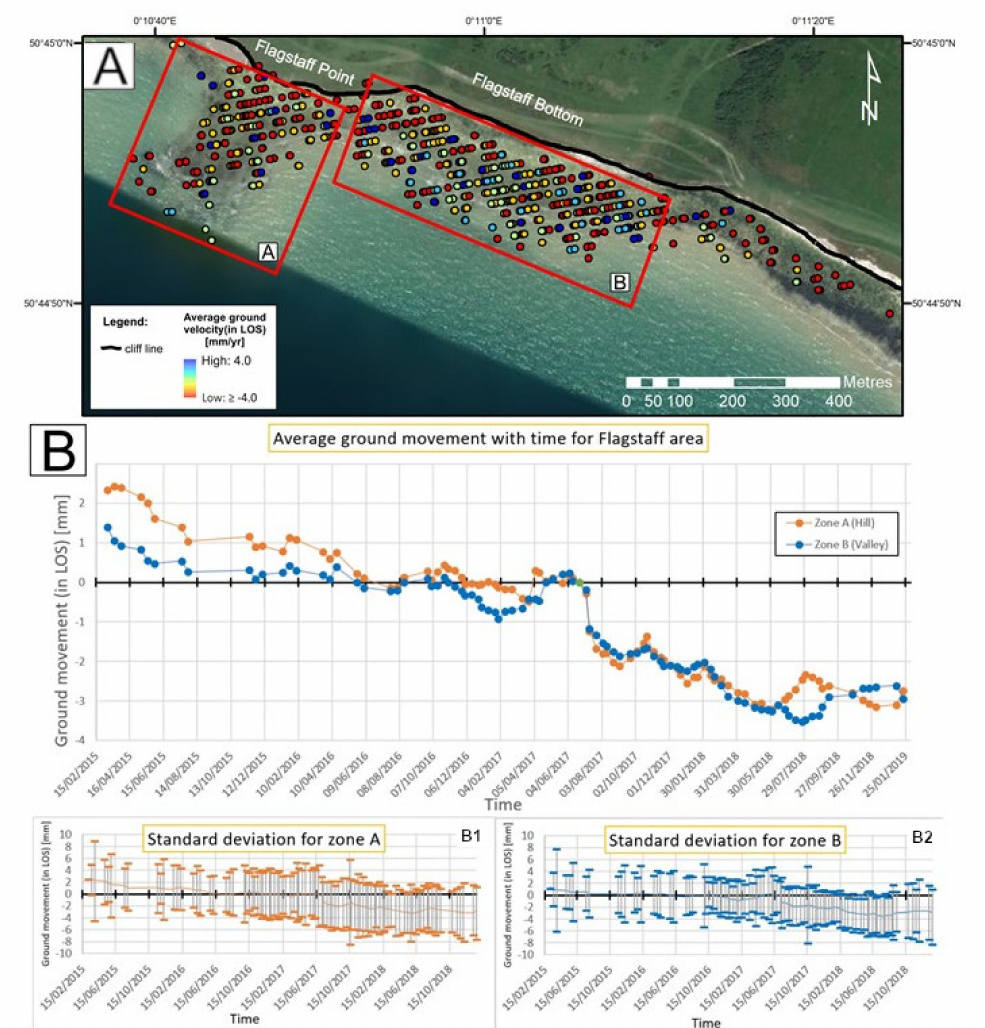
Figure 12. Results for the Flagsta ff research site. ( A ) shows an aerial view of the research site, with the cli ff line being marked. On top of the map, the average velocity of the PS points on the ground is shown in mm / yr, coloured adequately to the direction of the ground movement: red colours represent movement away from the satellite (downward), and blue colours mean movement towards the satellite (upwards). ( B ) shows the average ground movement with the time for the whole area, the vertical axis displaying the ground movement in mm, and the horizontal axis showing the time frame during which the analysis was done (from March 2015 until January 2019). Error bars on the plots ( B1 and B2 ) show the standard deviation calculated for the data, presented to visualise the variability. (Service